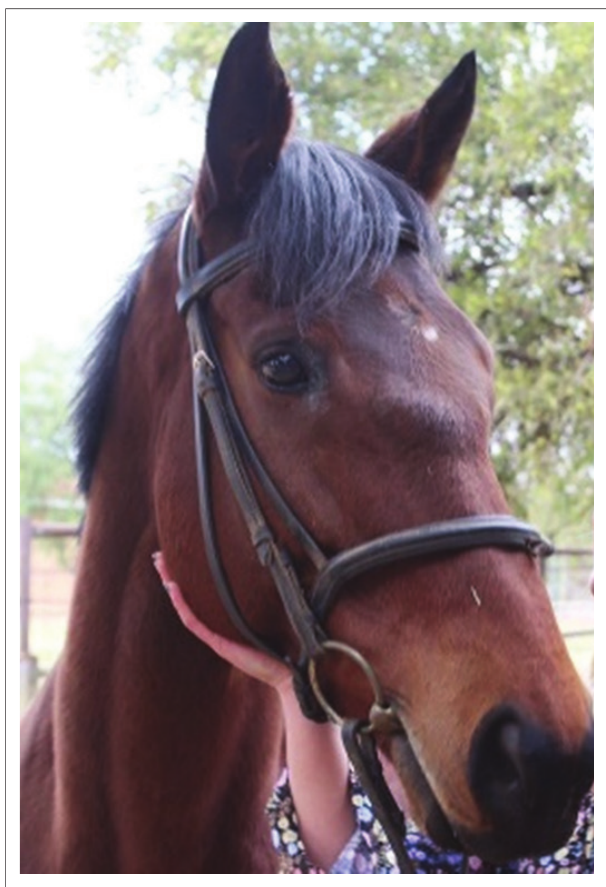
FIGURE 6: Eight months after the initial traumatic episode. A smaller area of swelling is still evident on the nasofrontal suture